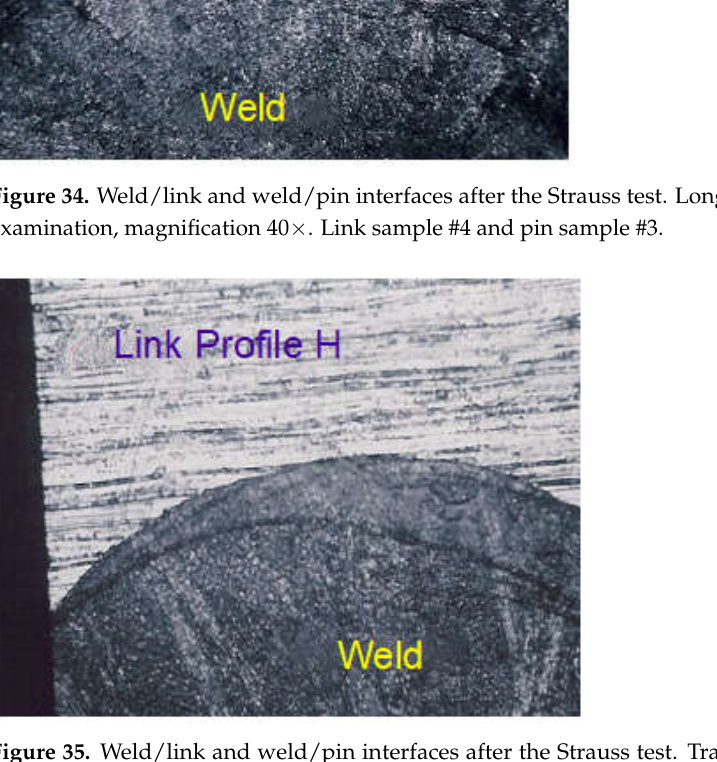
Figure 35. Weld/link and weld/pin interfaces after the Strauss test. Transversal surface. Optical examination, magnification 40 × . Link sample #4 and pin sample #3.